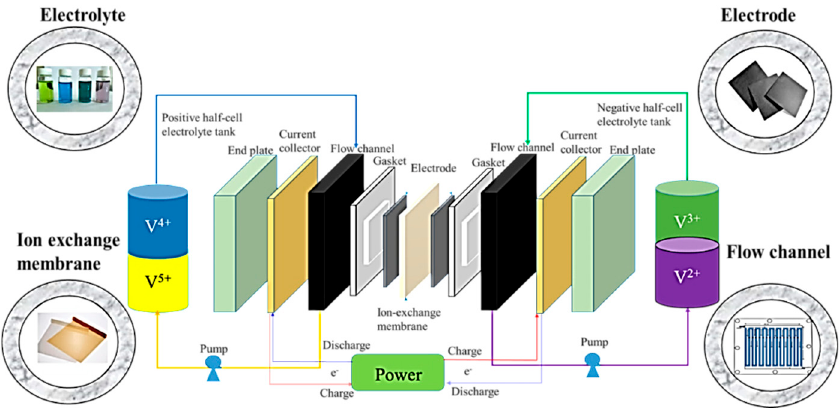
Figure 1. Component schematic of an all-vanadium redox flow battery (all-V RFB).